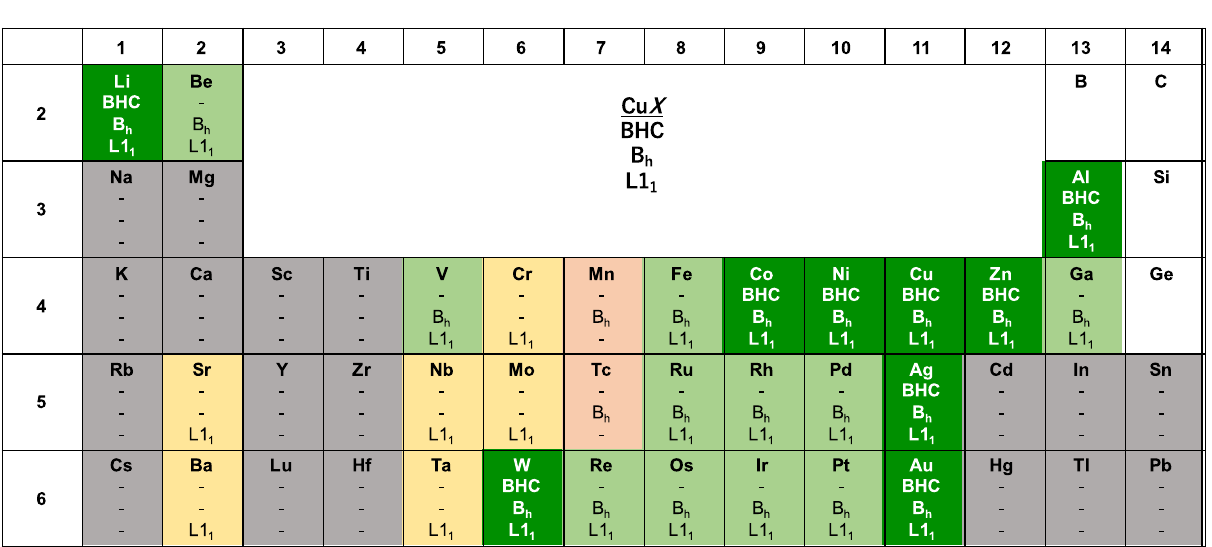
Figure 2. Periodic table for the Cu X compounds in the BHC, B h , and L1 1 structures. The dynamically stable structure j s are indicated. Cu X with X = Ca , Sr, Ba, Sc, Y, and Lu has the B1 structure rather than the L1 1 structure as a dynamically stable or unstable structure (see the Supplementary